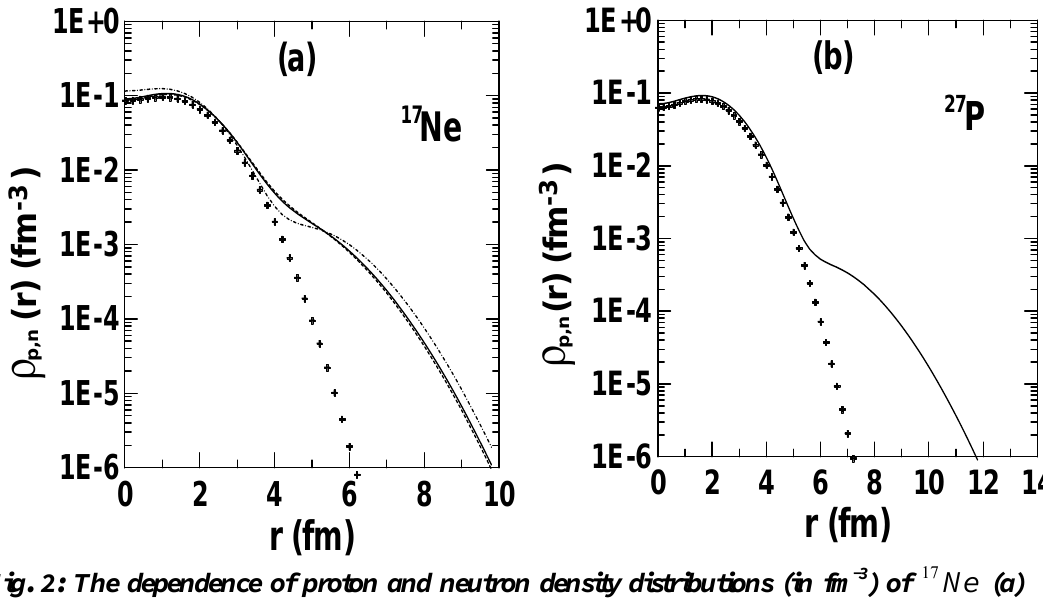
Fig. 2: The dependence of proton and neutron density distributions (in fm -3 ) of (a) and P 27 (b) on r (in fm). In (a), the solid, dashed and dash-dotted lines are the same as those of Fig. 1 (a) but for the calculated proton density distributions. In (b), the solid line is the same as that of Fig. 1 (b) but for the calculated proton density distribution. In (a) and (b), the plus symbols are the neutron densities of unstable proton-rich Ne 17 and P 27 nuclei.